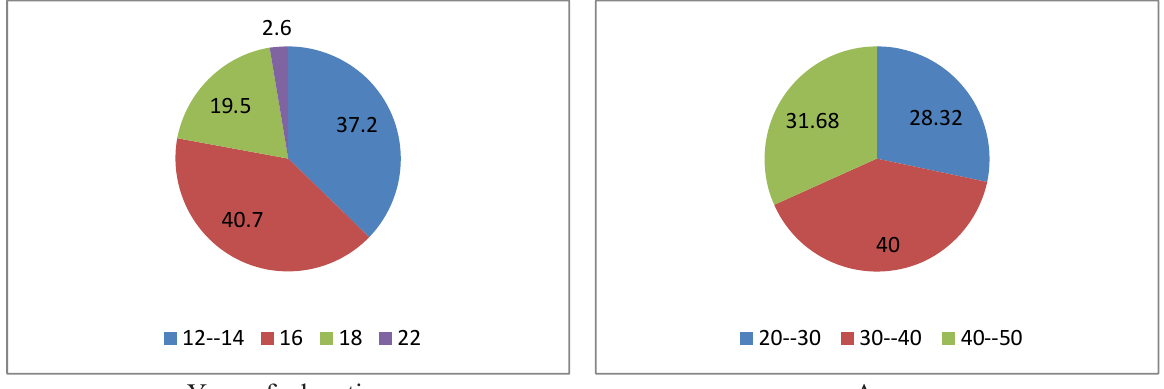
Fig. 2. Personal characteristics of the participants